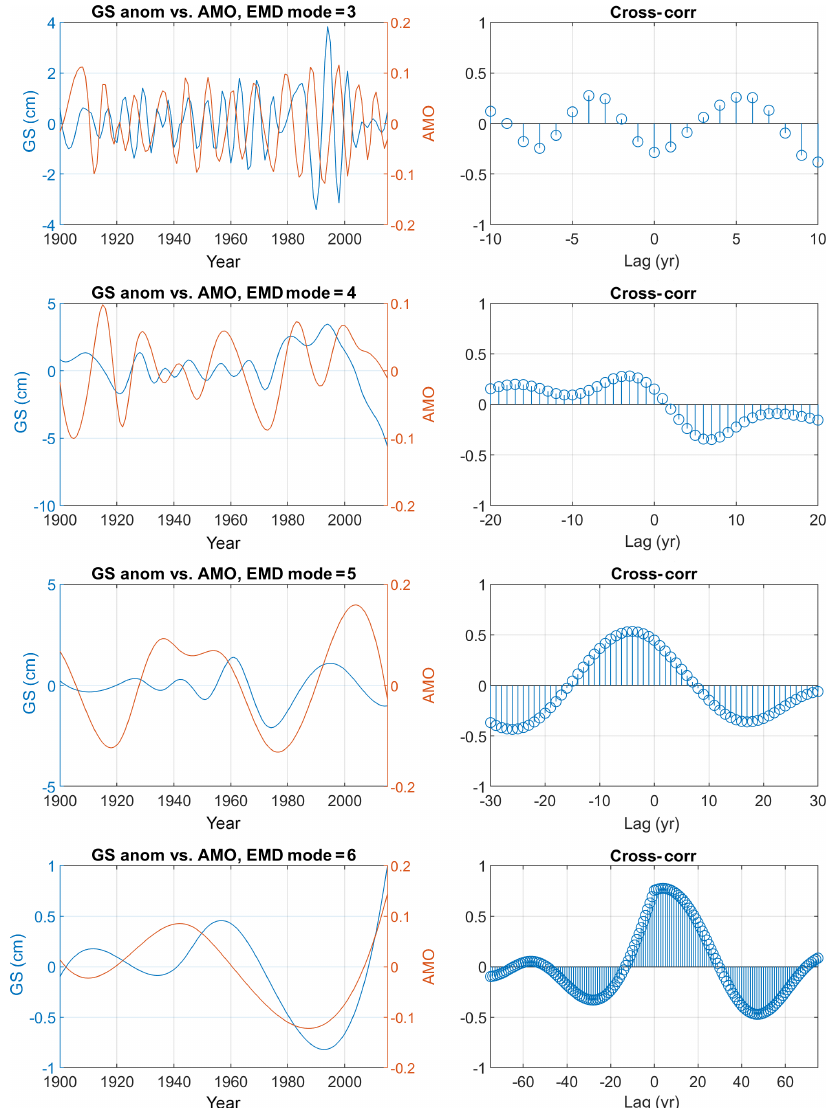
Figure 10. (left) Comparison of EMD oscillating modes of the monthly GS-MAB proxy (blue; units: sea level change across the GS in centimeters per degree latitude) and the AMO index (red). (right) Cross-correlation as a function of lag. There are a total of seven EMD modes; modes 2–6 are the oscillating